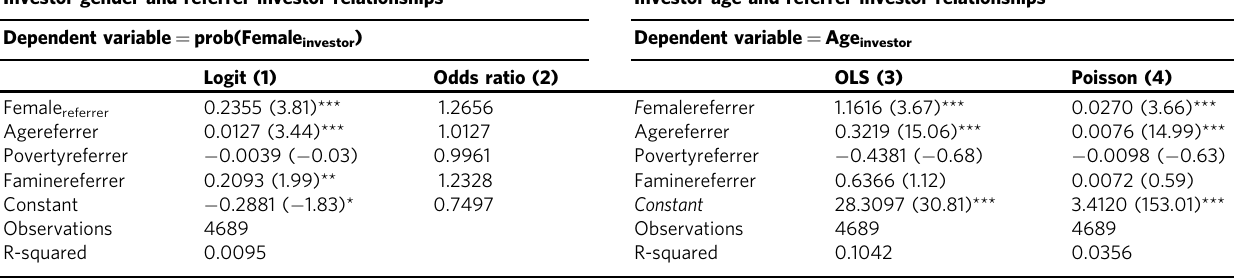
Table 3 Investor gender/age and referrer-investor relationships. Investor gender and referrer-investor relationships Investor age and referrer-investor